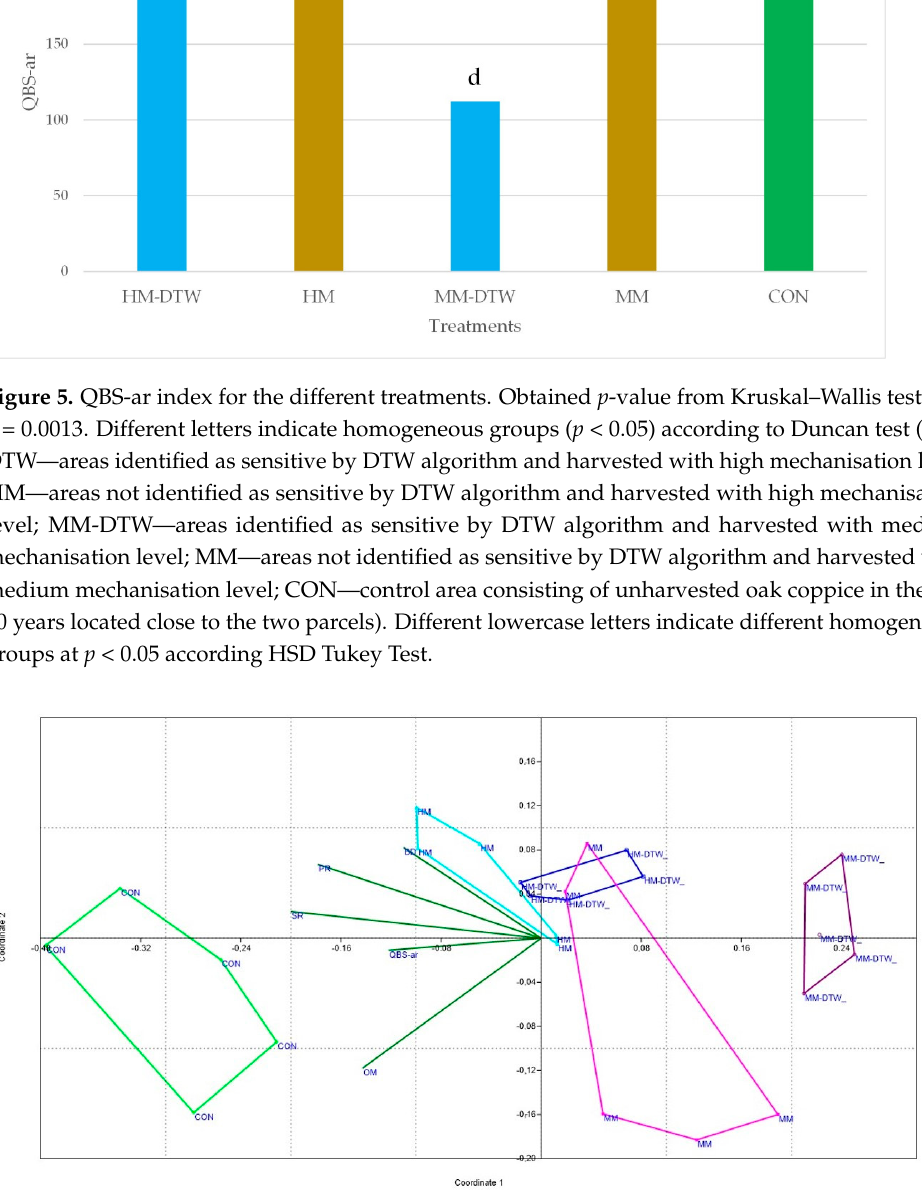
Figure 6. Non-metric multidimensional scaling (nMDS) analysis of the main indexes and indicators of the disturbed soil and the control (BD—bulk density; PR—penetration resistance; SR—shear resistance; OM—organic matter; QBS-ar—soil biological quality based on microarthropods soil bio- logical quality) (HM-DTW—areas identified as sensitive by DTW algorithm and harvested with high mechanisation level; HM—areas not identified as sensitive by DTW algorithm and harvested with high mechanisation level; MM-DTW—areas identified as sensitive by DTW algorithm and harvested with medium mechanisation level; MM—areas not identified as sensitive by DTW algorithm and harvested with medium mechanisation level; CON—control area consisting of unharvested oak coppice in the last 20 years located close to the two